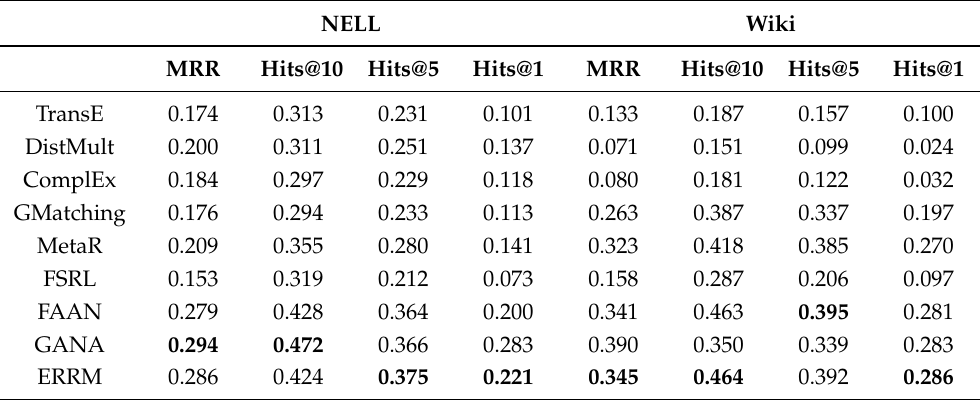
Table 3. Comparison of results of our model and baseline model on a 5-shot task on NELL and Wiki (best values in bold).